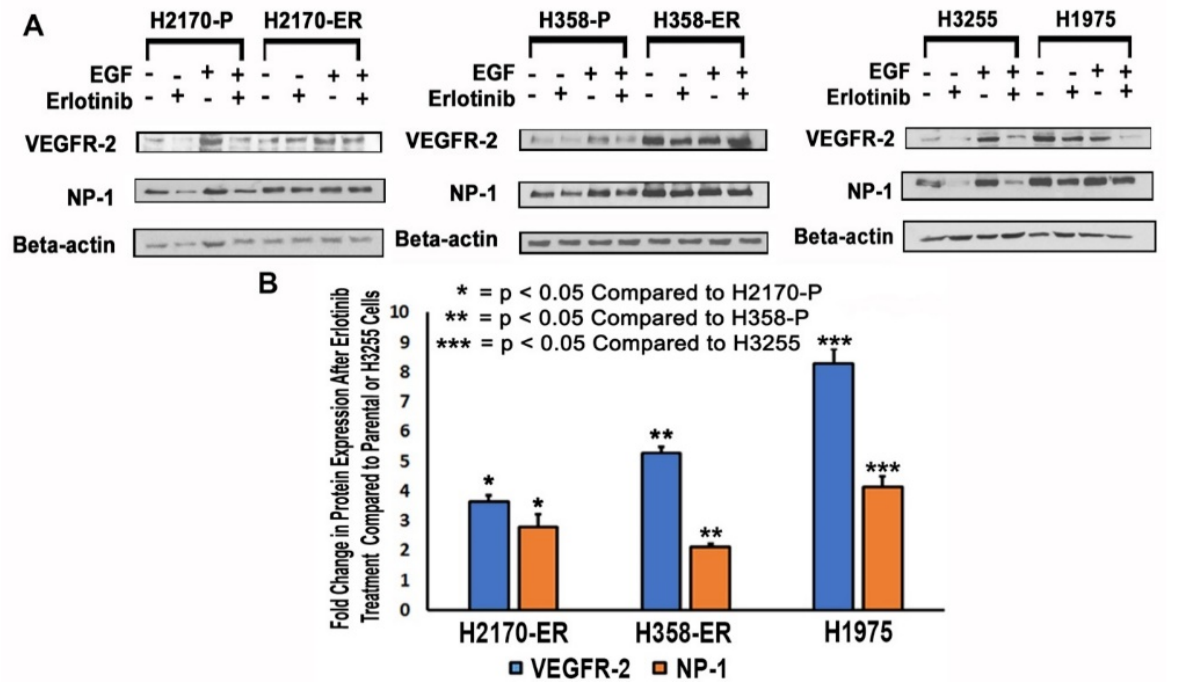
Figure 2. Modulation of VEGFR-2 and NP-1 protein expression in NSCLC cell lines . ( A ) For the analysis, 2.5 × 10 5 H2170-P/ER, H358-P/ER, H1975, and H3255 cells were seeded in Petri-dishes. Cells were allowed to adhere and grow for 24 h, then starving media (RPMI with 0.5% BSA) was added for 24 h. Cells were then treated with Erlotinib (10 µM Erlotinib) for 24 h and/or with ligands (15 ng/mL EGF for 2.5 min in starving media) before collection of cell lysates. Immunoblotting was then performed. ( B ) The data were normalized with beta-actin, and the graphical representation is rela- tive to protein expression of the corresponding parental or single-mutant cell line. The modulations were calculated by densitometric analysis using ImageJ software. Statistical analysis was performed and it was demonstrated that the results were statistically significant ( p < 0.05) by way of a two- tailed t -test analysis.